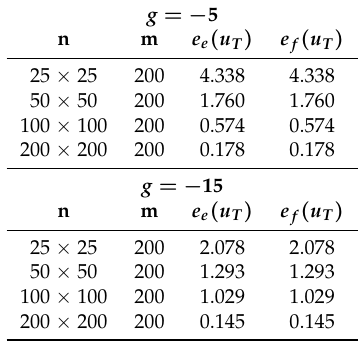
Table 5. Two-dimensional problem with h-smoothing. Relative L 2 error for the temperature at the final time with respect to the finest grid solution using the presented method ( e f ( u T ) = e e ( u T ) ). g = − 5 n m e e ( u T